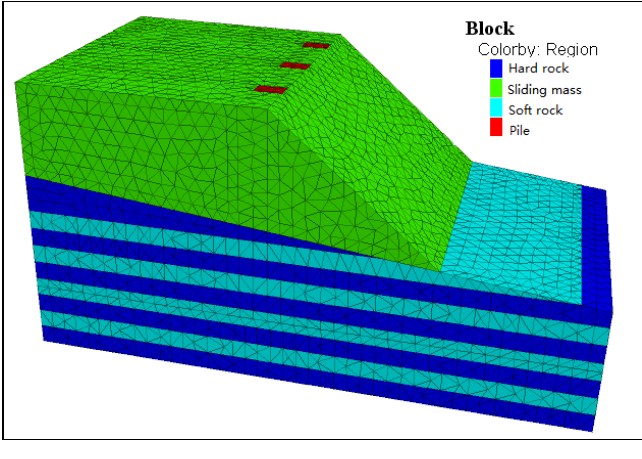
Figure 16. Discrete element model.